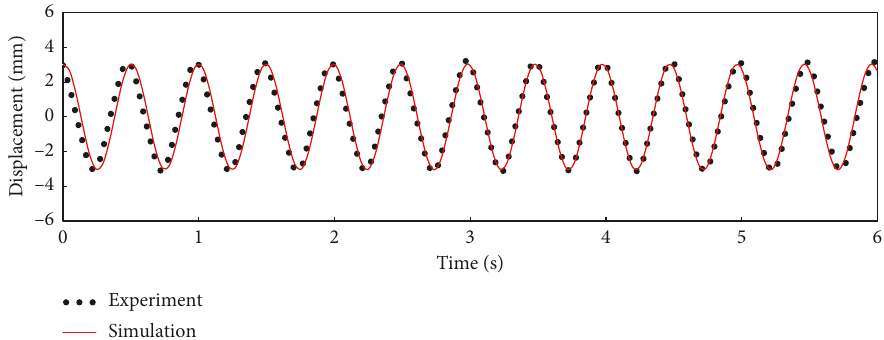
Figure 7: Displacements of the offshore platform under sinusoidal excitation.